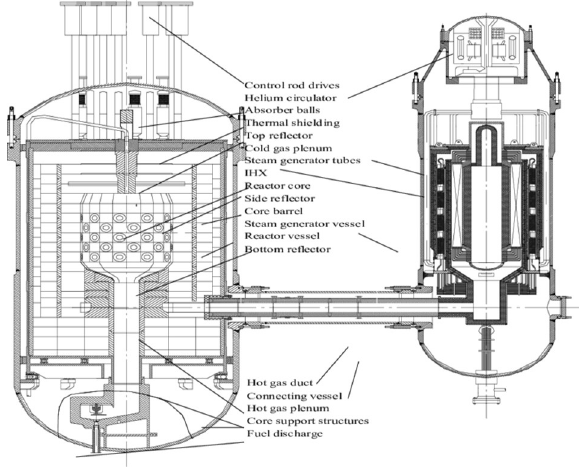
Figure 2. Plan View of the HTR-10